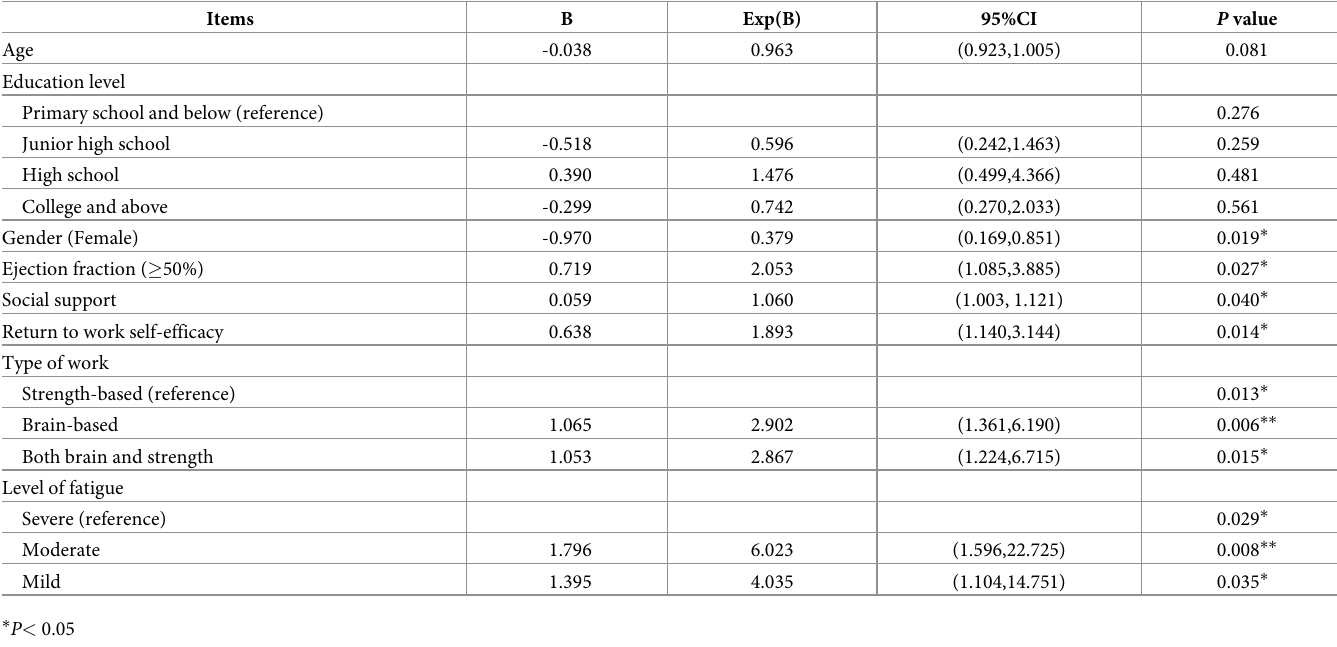
Table 4. Multivariable logistic regression of the factors influencing return to work (n =